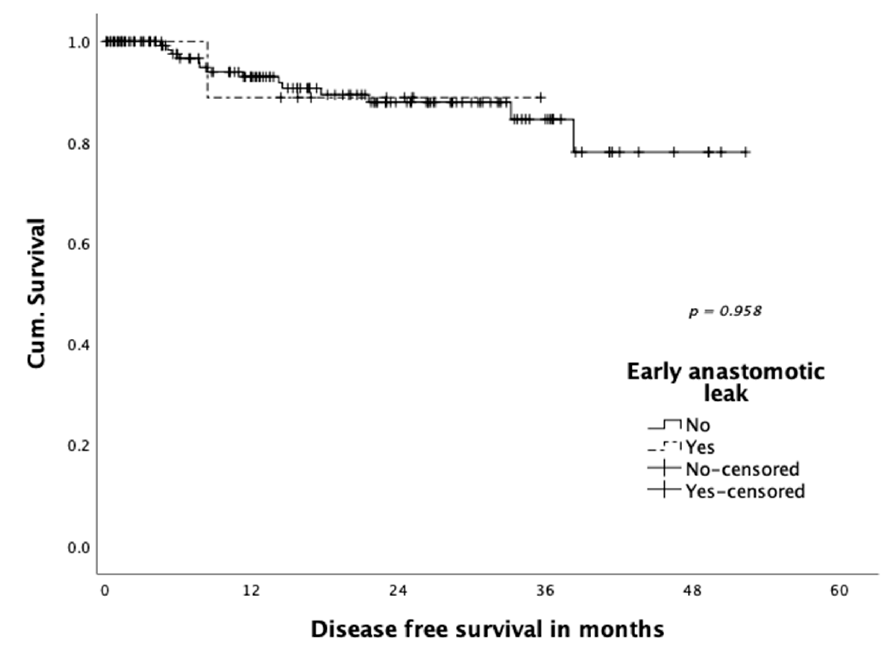
Figure 1. Disease-free survival according to early anastomotic